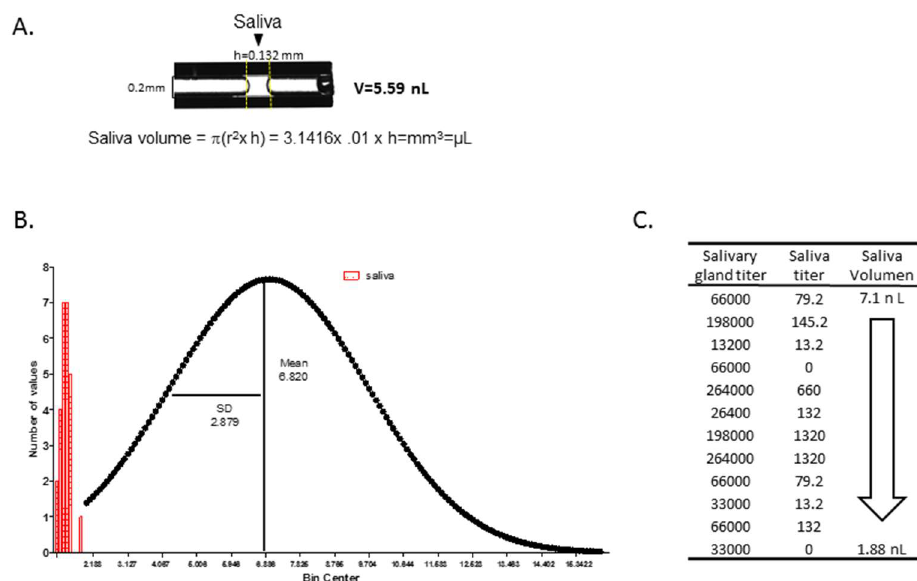
Figure 5. Frequency and Gaussian distribution of saliva volume in Ae. aegypti . The average saliva volume produced by Ae. aegypti , was determined by forcing mosquitoes to salivate into a calibrated capillary tube (0.2 mm inner diameter) filled with immersion oil type B. Twenty six mosquitoes were allowed to salivate into the oil at room temperature for 1 h. ( A ) An image of a capillary with saliva was captured after the mosquito expectorated. The height of saliva was measured using a digital fractional caliper (presicion: ± 0.02 mm). The volume of saliva was calculated using the cylinder volume formula (V = π (r 2 × h) = 3.1416 × 0.01 × h = mm 3 or µ L). ( B ) Frequency distribution (histogram) and Gaussian distribution using GraphPad Prism software. The mean value at the center of the distribution and SD is a measure of the width of the distribution. Aedes mosquitoes salivated an average of 6.82 ± 2.88 nL. ( C ) R99659 titers were determined from a range of saliva volumes between 1.8 and 7 nL. We did not see a strong correlation between virus titers in salivary gland and the volume of saliva. Arrow indicates saliva descending volumes between 7.1 nL and 1.88